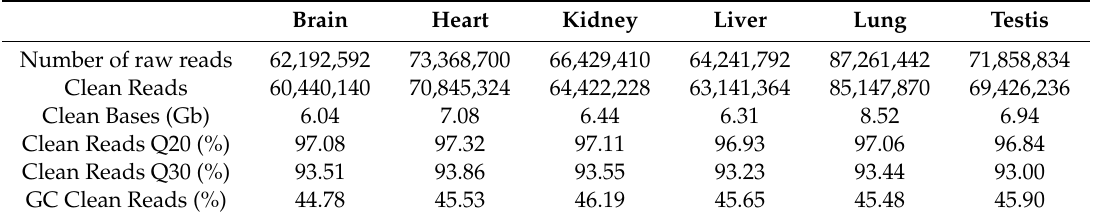
Table 1. Summary of transcriptome sequencing based on RNA samples from six di ff erent tissues. Brain Heart Kidney